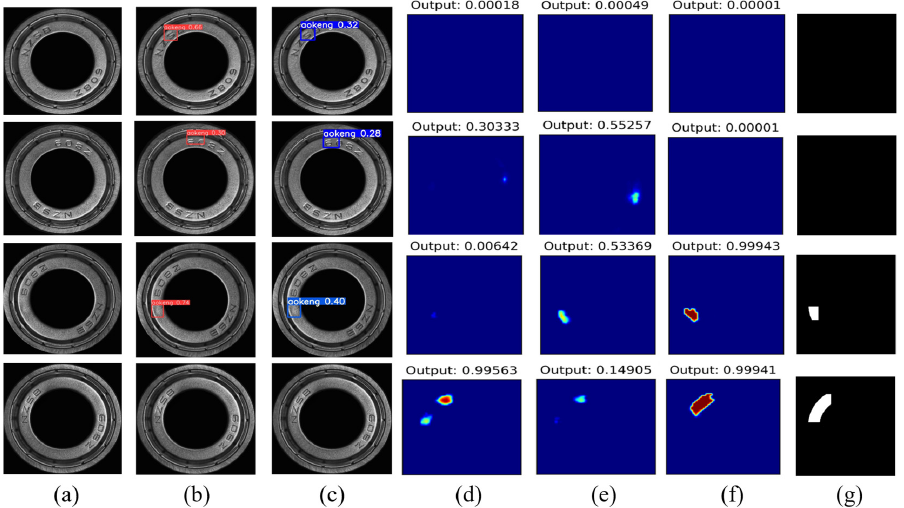
Figure 11. The result images of different methods. ( a ) Original image. ( b ) Yolov6. ( c ) Yolov7. ( d ) MixSeg. ( e ) SegDecNet. ( f ) PMG-Net. The first two rows are the data of non-defective bearings, and the last two rows are the data of defective bearings. ( g ) Ground truth. Table 5. Performance of every individual module on the bearing dataset.